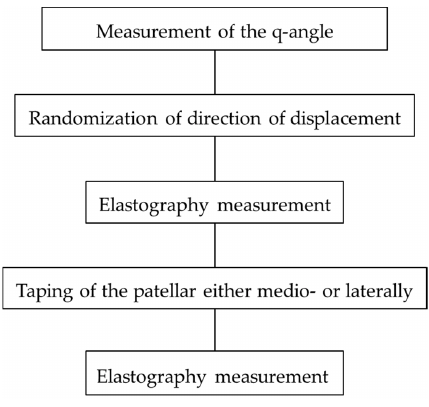
Figure 2. Schematic flow of the study.